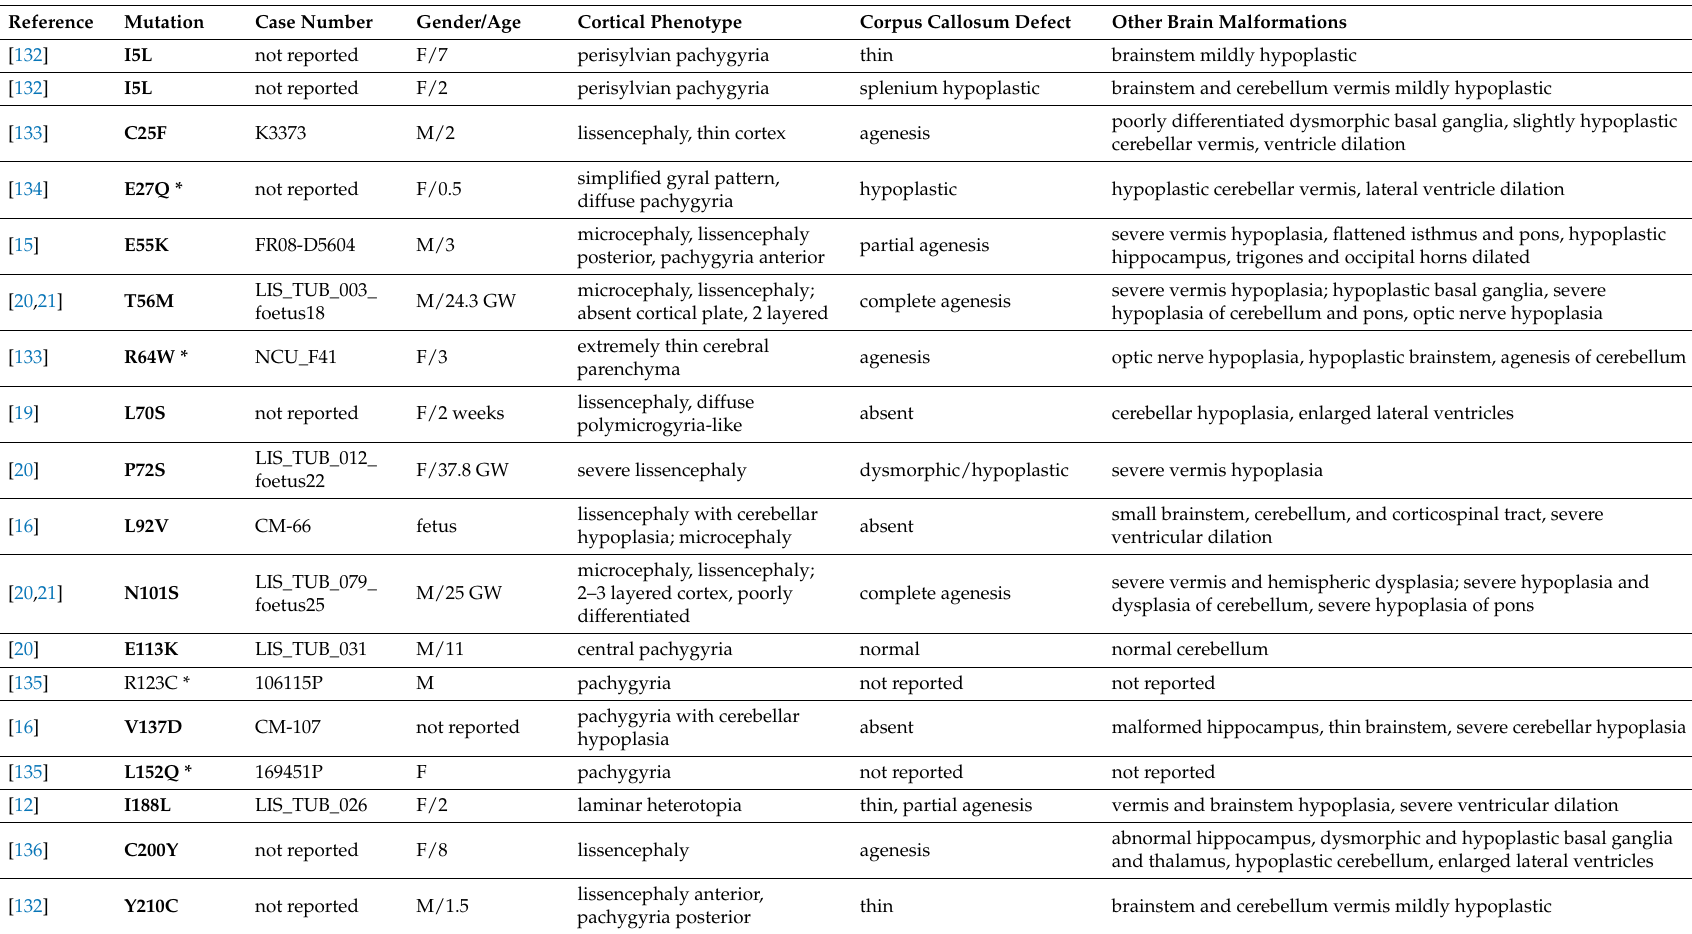
Table 3. Tuba1a mutations leading to lissencephaly spectrum